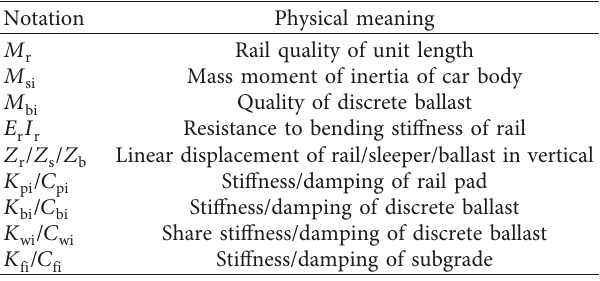
Table 2: Notation used in the track subsystem.